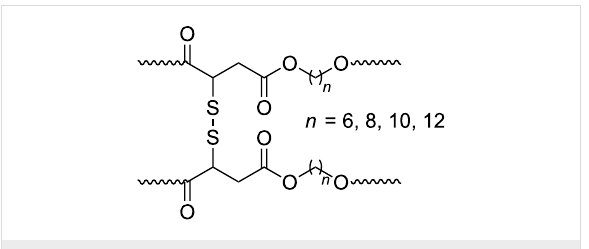
Figure 12: Oxidized poly(hexanediol-2-mercaptosuccinate)